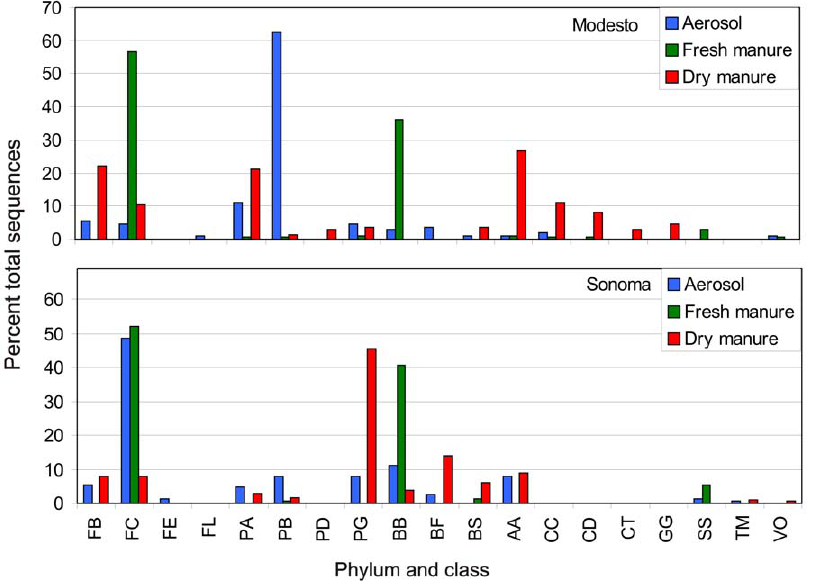
Figure 5. Percent distribution of all sequences from each isolation source assigned to bacterial classes. Top panel are sequences from Modesto dairy. Bottom panel are sequences from Sonoma dairy. Phylum class designations: FB = Firmicutes-Bacilli ; FC = Firmicutes-Clostridia ; FE = Firmicutes-Erysipelotrichi ; PA = a -Proteobacteria ; PB = b -Proteobacteria ; PD = d -Proteobacteria ; PG = c -Proteobacteria ; BB = Bacteroidetes-Bacteroidia ; BF = Bacteroidetes-Flavobacteria ; BS = Bacteroidetes-Sphingobacteria ; AA = Actinobacteria-Actinobacteria ; CC = Chloroflexi- Caldilineae ; CD = Chloroflexi-Dehalococcoidetes ; CT = Chloroflexi-Thermomicrobia ; GG = Gemmatimonadetes-Gemmatimonadetes ; SS = Spirochaetes-Spirochaetes ; TM = Tenericutes-Mollicutes ; and VO = Verrucomicrobia-Opitutae .